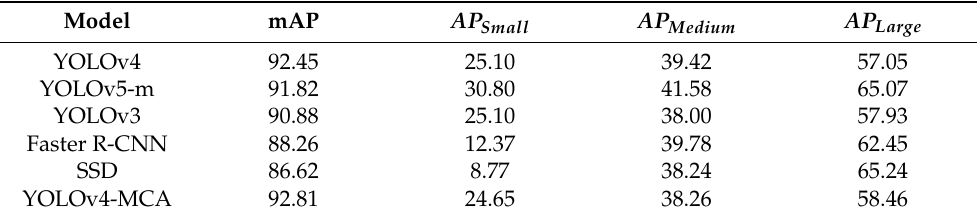
Table 5. The performance comparison of algorithms on